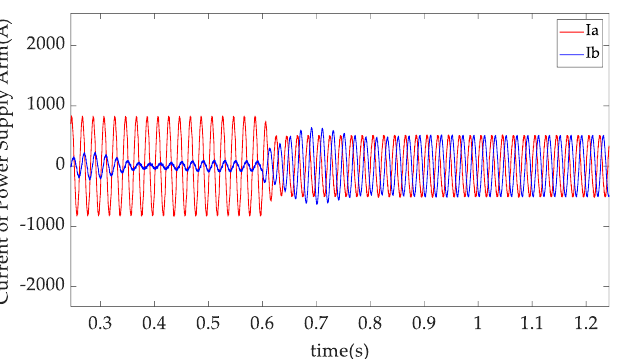
Figure 23. Current of power supply arms before and after the VSG control adopted.